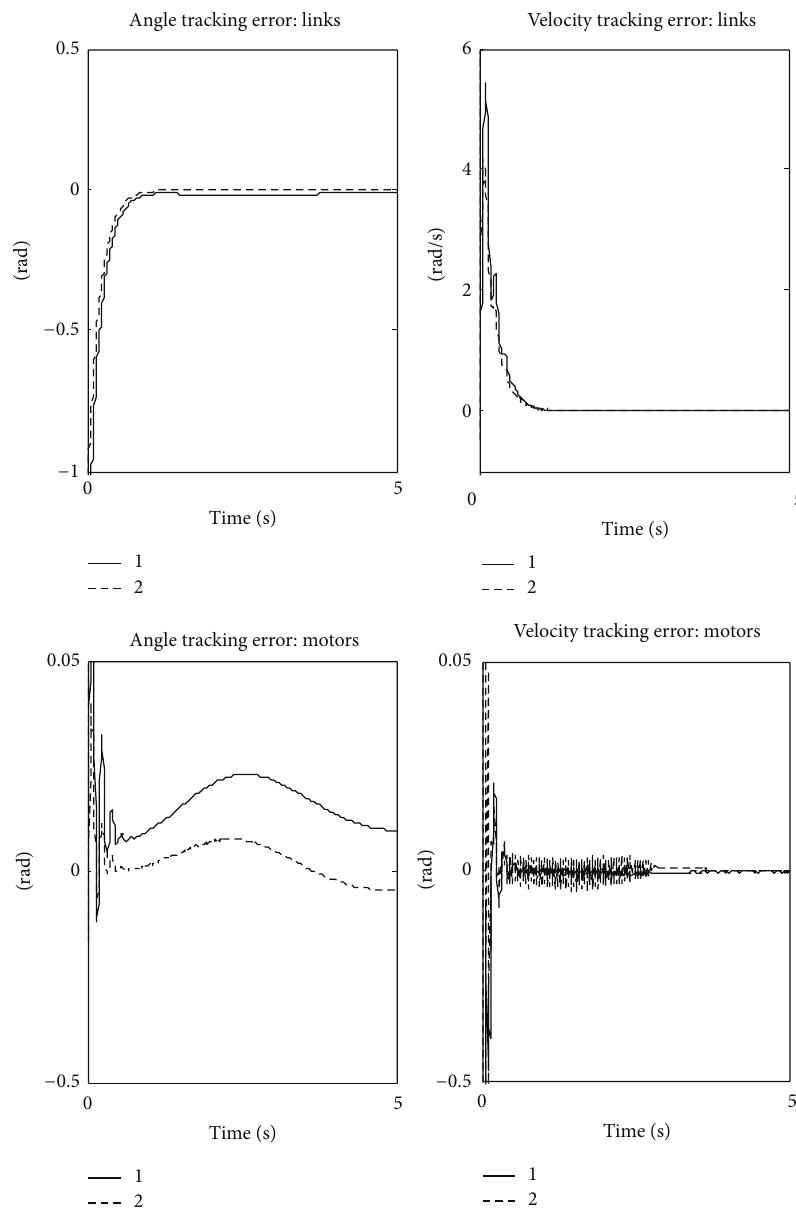
Figure 5: Tracking links angles and velocity